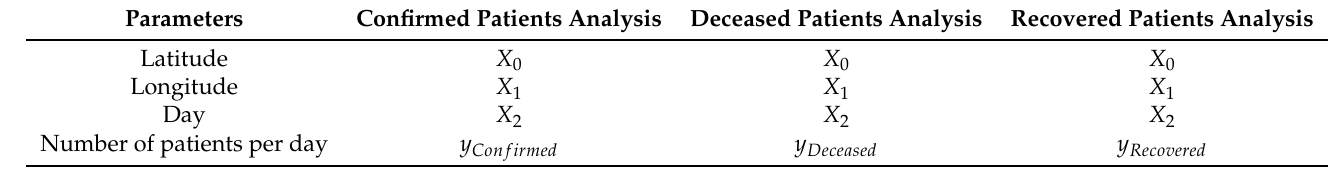
Table 2. Input and output parameters defined and used in GP to obtain symbolic expression for estimation of number of confirmed/deceased patients for each state and recovered patients for the entire